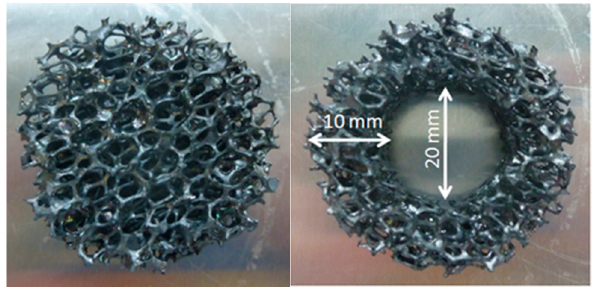
Figure 12. Pictures of a β -SiC foam before ( left ) and after ( right ) drilling.